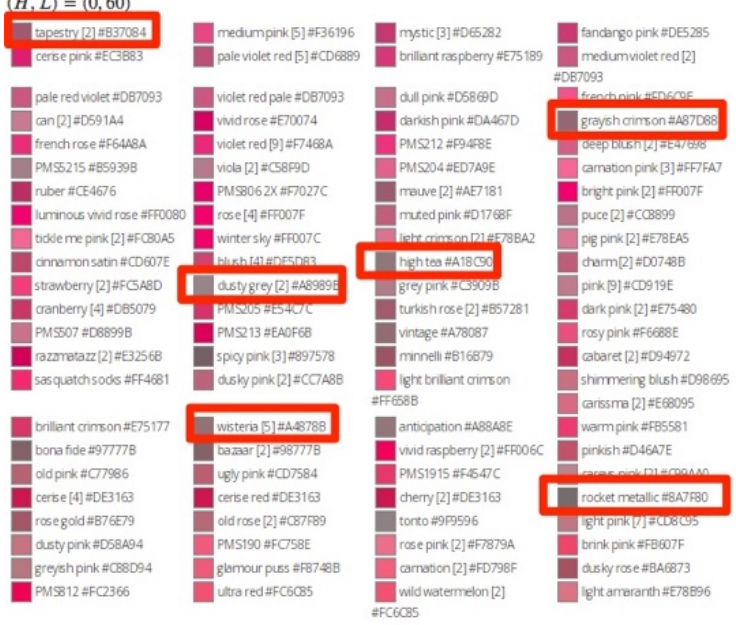
Figure 2. The ( H , L ) = (0, 60) color group. the colors in the red boxes may tend to be described more Figure 2. The ( (cid:1834) , (cid:1838) ) = (0, 60) color group . the colors in the red boxes may tend to be described more as gray based on human senses. as gray based on human senses. Table 1. Descriptions of the color name for the same color are different.